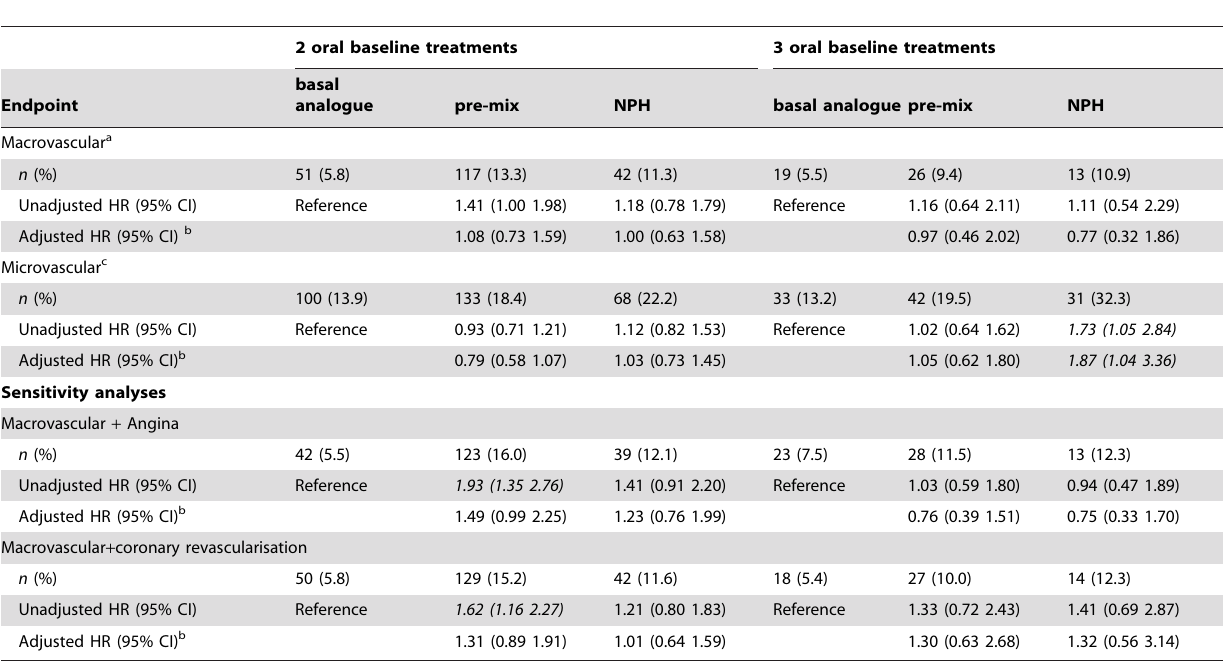
Table 3. Comparison of incident macro- and micro-vascular disease between insulin treatment groups.